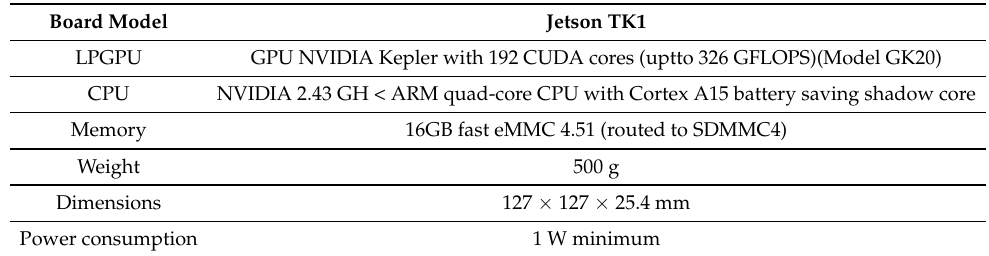
Table 1. Technical specifications of the NVIDIA Jetson TK1 development board used in the original flight